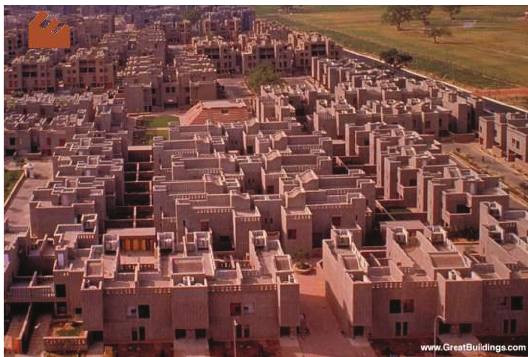
Figure 10. Asian Games Village, New